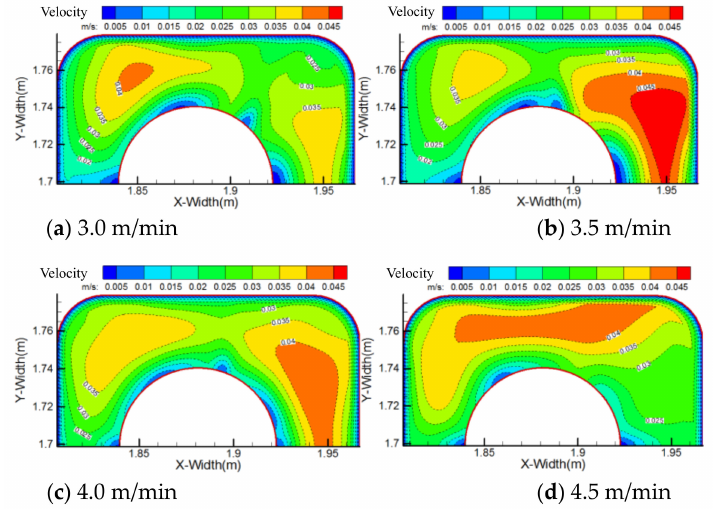
Figure 10. The flow speed distribution of molten steel on the surface of mold under different casting